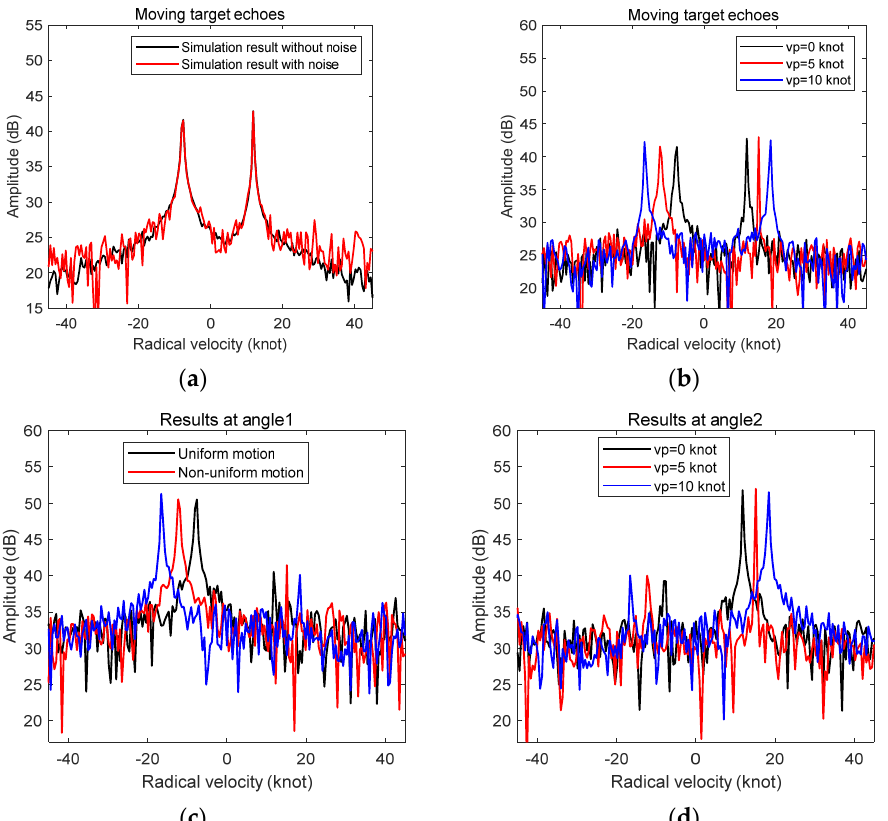
Figure 4. Target echoes simulation results for shipborne HFSWR in the case of uniform linear platform motion: ( a ) channel results with and without noise, ( b ) channel results at different velocities, ( c ) beam results at angle 1, ( d ) beam results at angle 2.